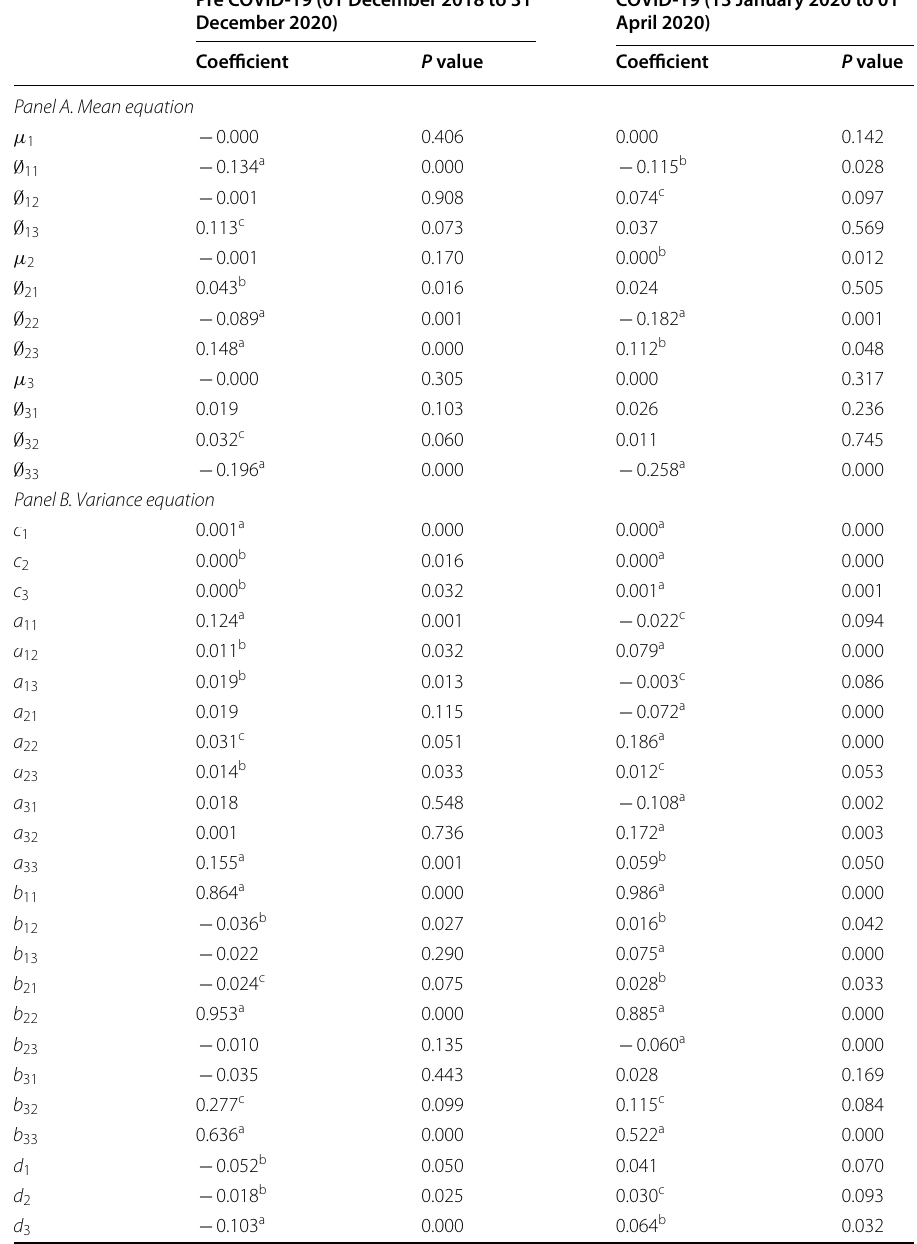
Table 7 Estimates of tri-variate VAR-AGARCH for the Bitcoin, Ethereum, and Litecoin (Robustness